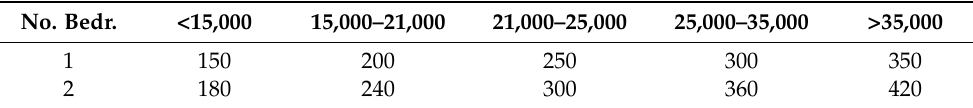
Table 5. Monthly fee in euros to be paid for the occupation of one- and two-bedroom autonomous regime housing, depending on the income of the household or cohabitation